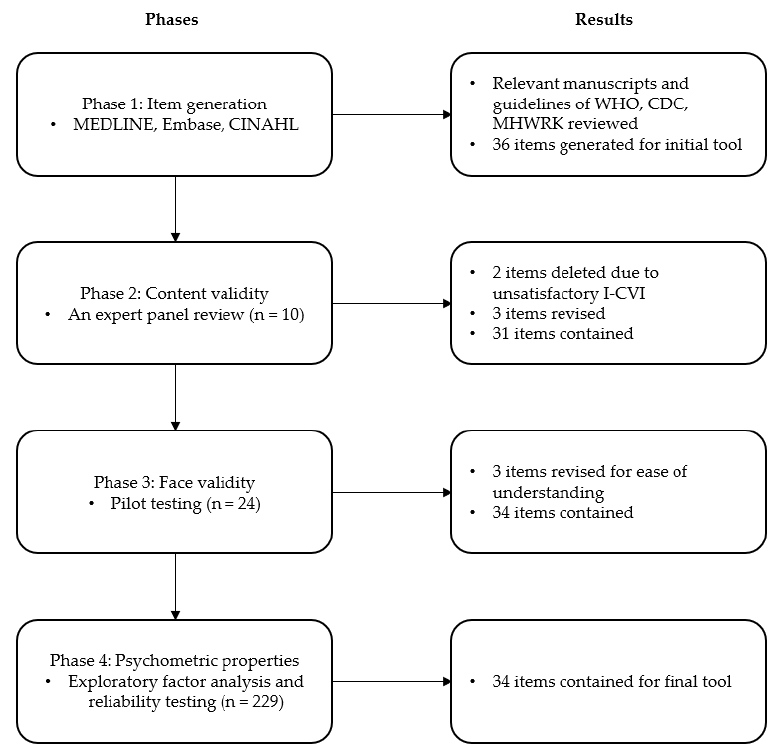
Figure 1. A flow diagram of the development and validation process.